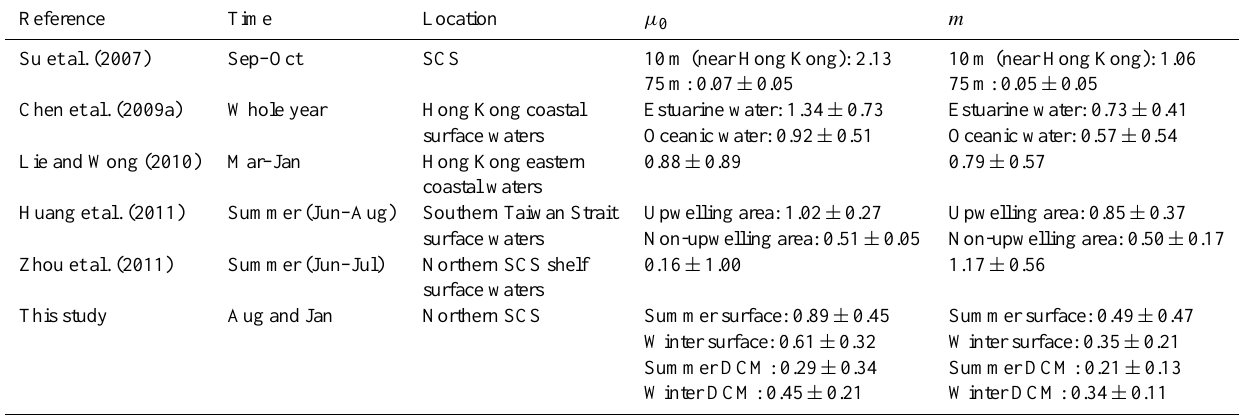
Table 2. A list of studies with phytoplankton growth rate ( µ 0 , d − 1 ) and microzooplankton grazing rate ( m ,d − 1 ) data (mean ± sd) in the SCS using the dilution